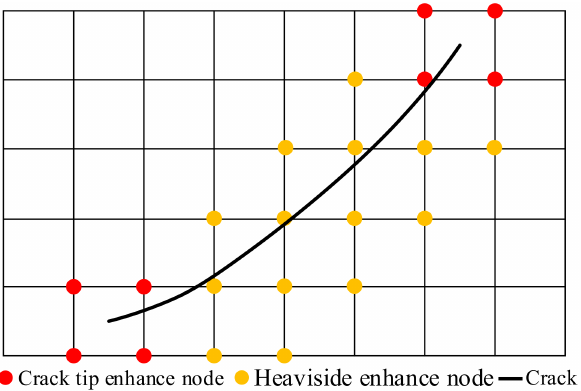
Figure 1. The crack enhancement of